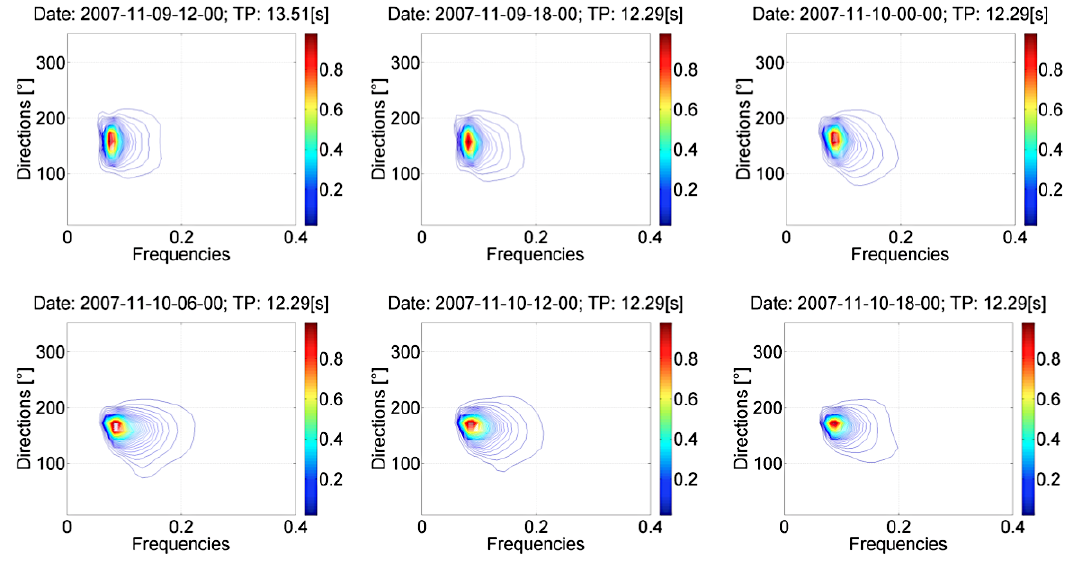
Figure 5. Evolution of the directional wave spectrum during the Andrea storm, from 12:00UTC 9 November 2007 to 11 November 2007 18:00UTC